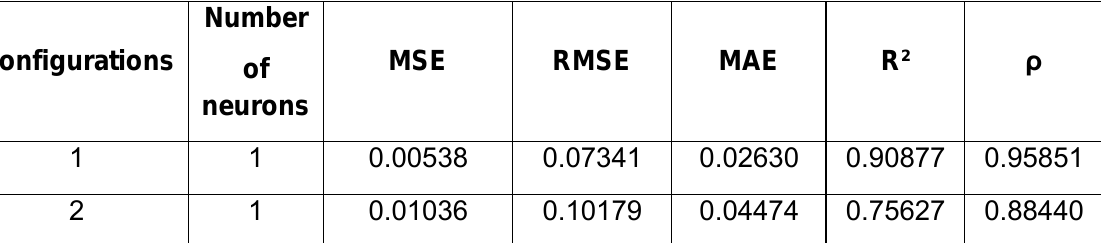
Table 3. Characteristics of the best